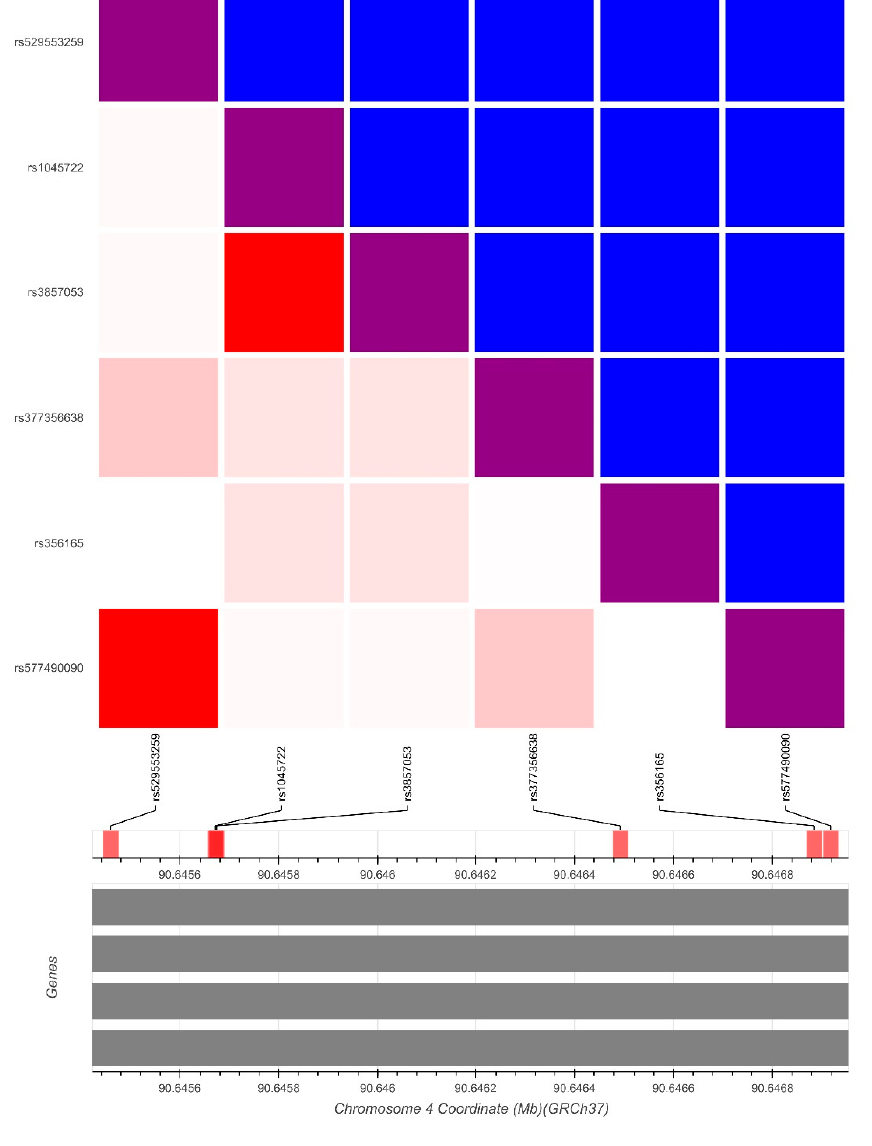
Figure 2. Linkage disequilibrium (LD) structure and physical gene map of the SNCA gene. Blue cells represent D’ correlation; red cells represent R2 correlation. Red cells indicate strong LD; pink cells-intermediate or ambiguous; white cells—evidence for historical recombination. Analysis of linkage disequilibrium of identified variants in the 3 ′ UTR region of SNCA gene performed via LDmatrix Tool (https://ldlink.nci.nih.gov; accessed at 26 September 2021).